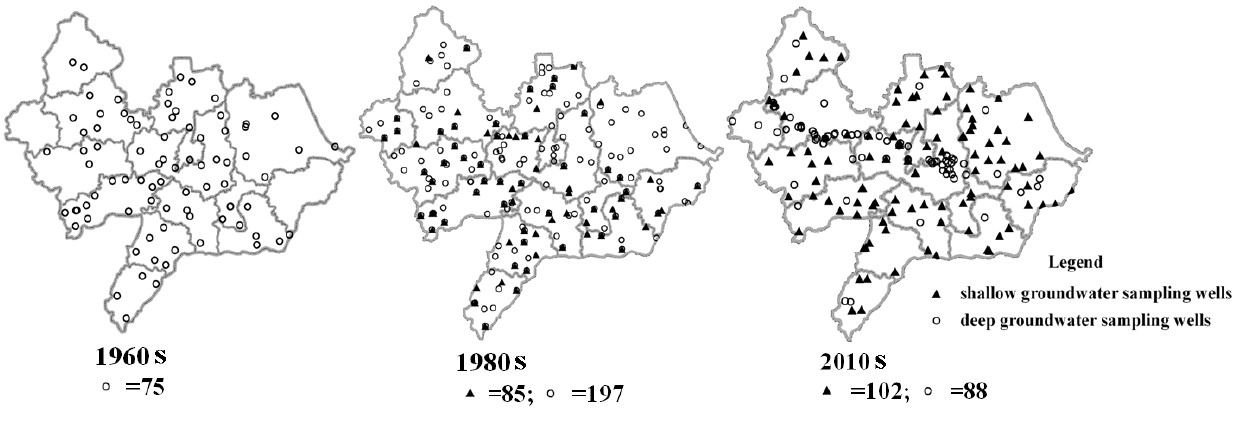
Figure 4. Location of groundwater sampling wells from 1966 to 2014 (divided into three decades: 1960s, 1980s and